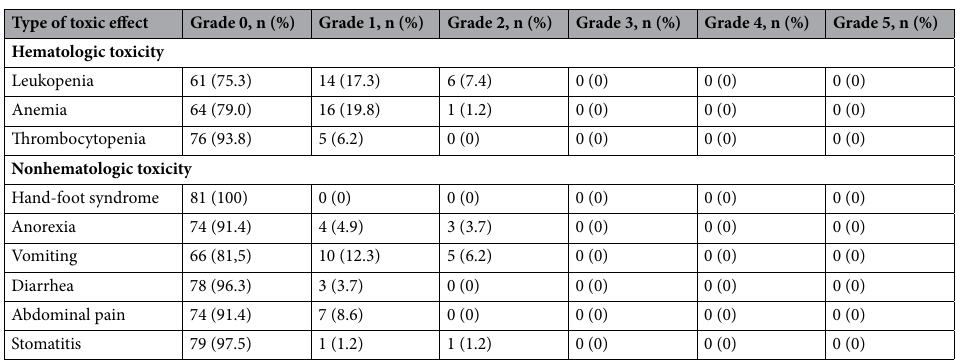
Table 3. Acute toxicities during proton beam therapy. Abbreviations: see Table 1. Some patients experienced more than one toxicity. National Cancer Institute Common Terminology Criteria for Adverse Events, version